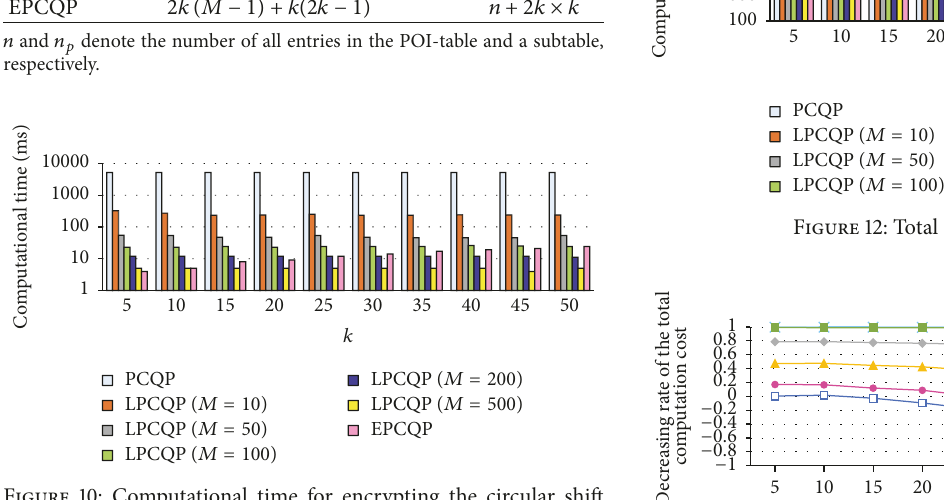
Figure 10: Computational time for encrypting the circular shift matrix.